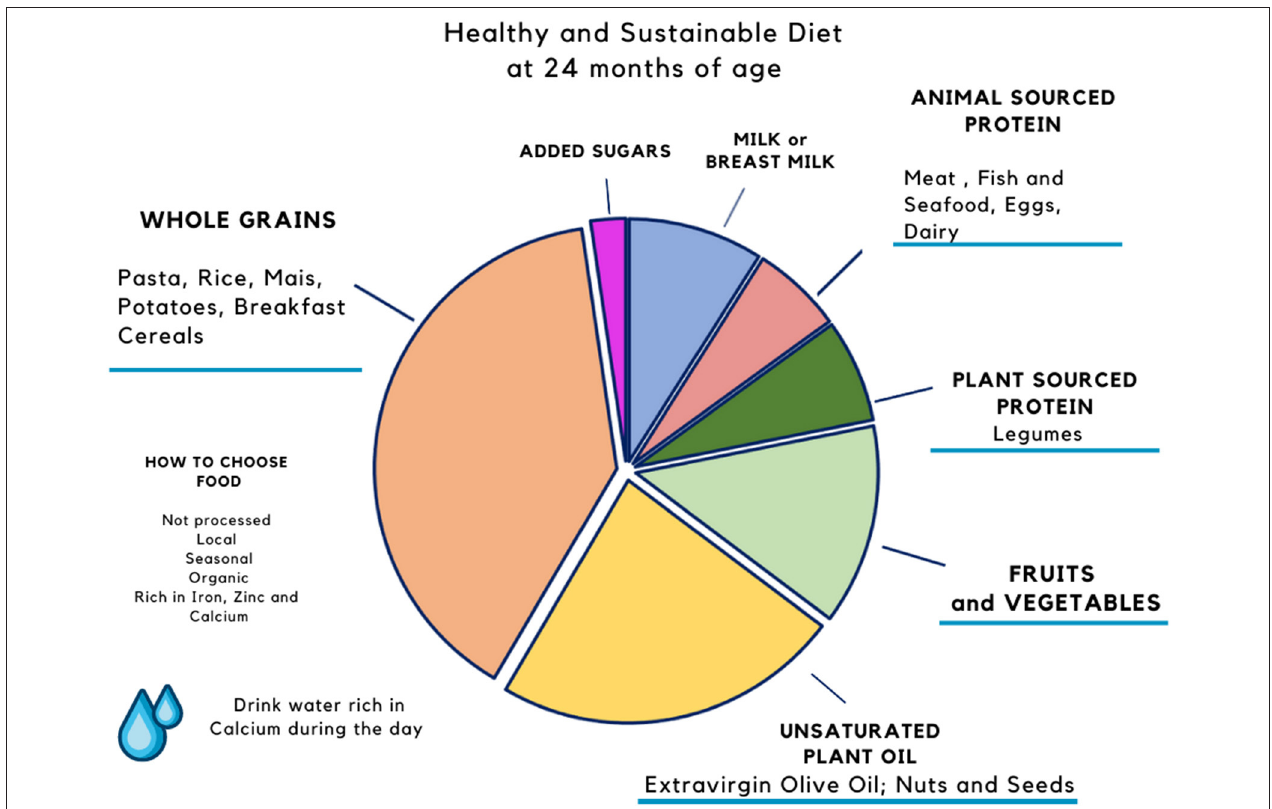
FIGURE 1 | Healthy and sustainable diet at 6 months of age. Proposal of diet at 6 months of age. Percentages refer to the total amount of calories required per day by each food group for a 6-months old baby. From Mazzocchi et al. (15).